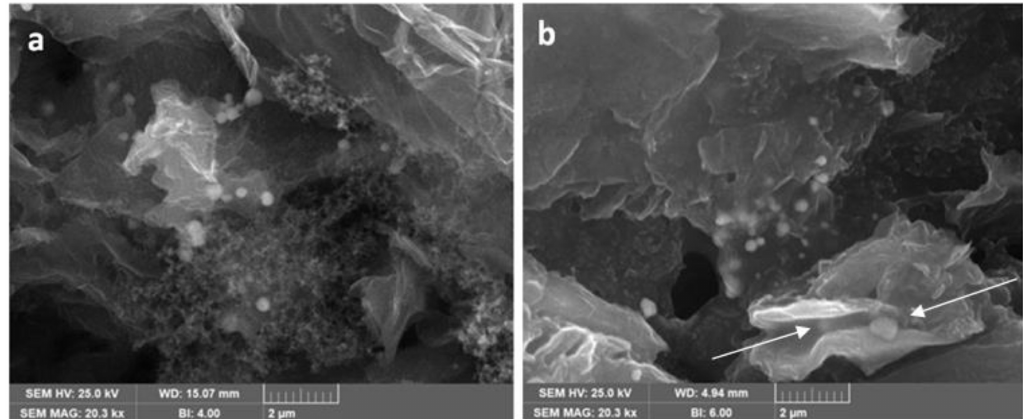
Figure 3. Scanning electron microscopy (SEM) micrograph of the Sn-RGO electrode before ( a ) and after ( b ) the electrochemical